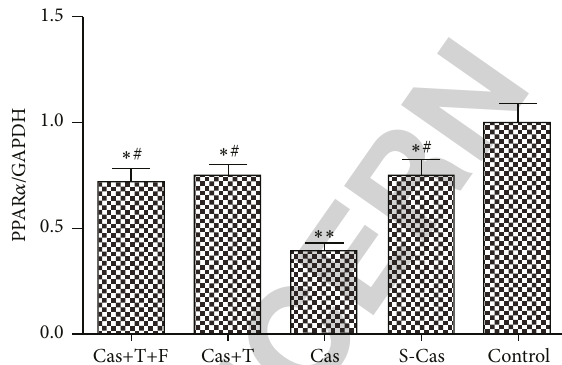
Figure 1: Effects of castration and testosterone replacement on the mRNA expression of PPAR 𝛼 in heart. Values are means ± SD; 𝑛 = 3 . S-Cas: sham-castration; Cas: castration; T: testosterone; F: flutamide. ∗ 𝑃 < 0.01 and ∗∗ 𝑃 < 0.001 versus control group; # 𝑃 < 0.01 versus